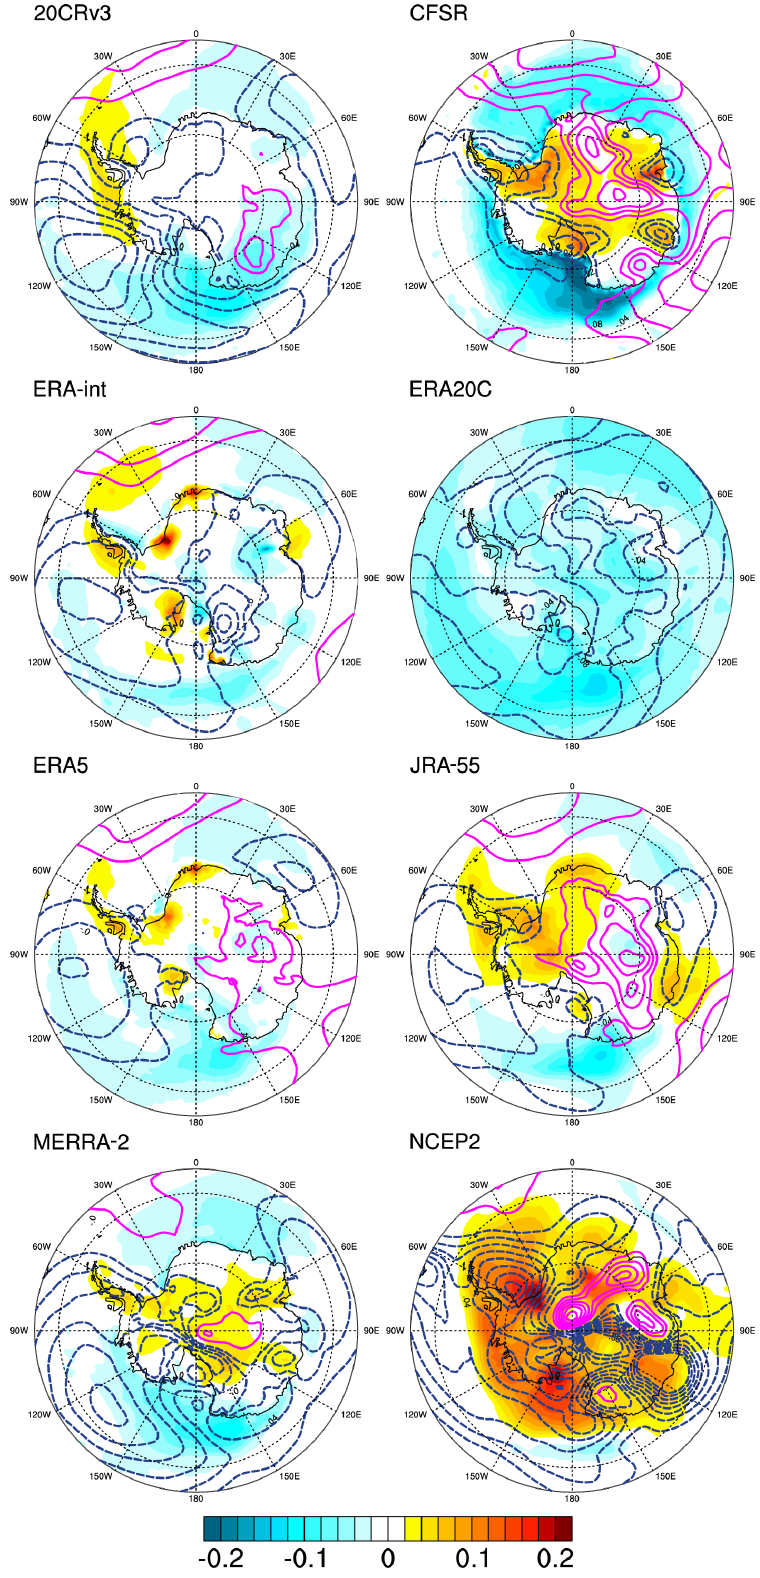
Figure 1. 1980–2010 trends in annual-mean SAT (shading: ◦ C/year) and MSLP (contour lines: positive trends in blue, negative trends in magenta, with contour spacing = 2.5Pa/year) for eight individual reanalyses (refer to Table 1 for details). Trend patterns for each month are shown in the Supplement as Figs.